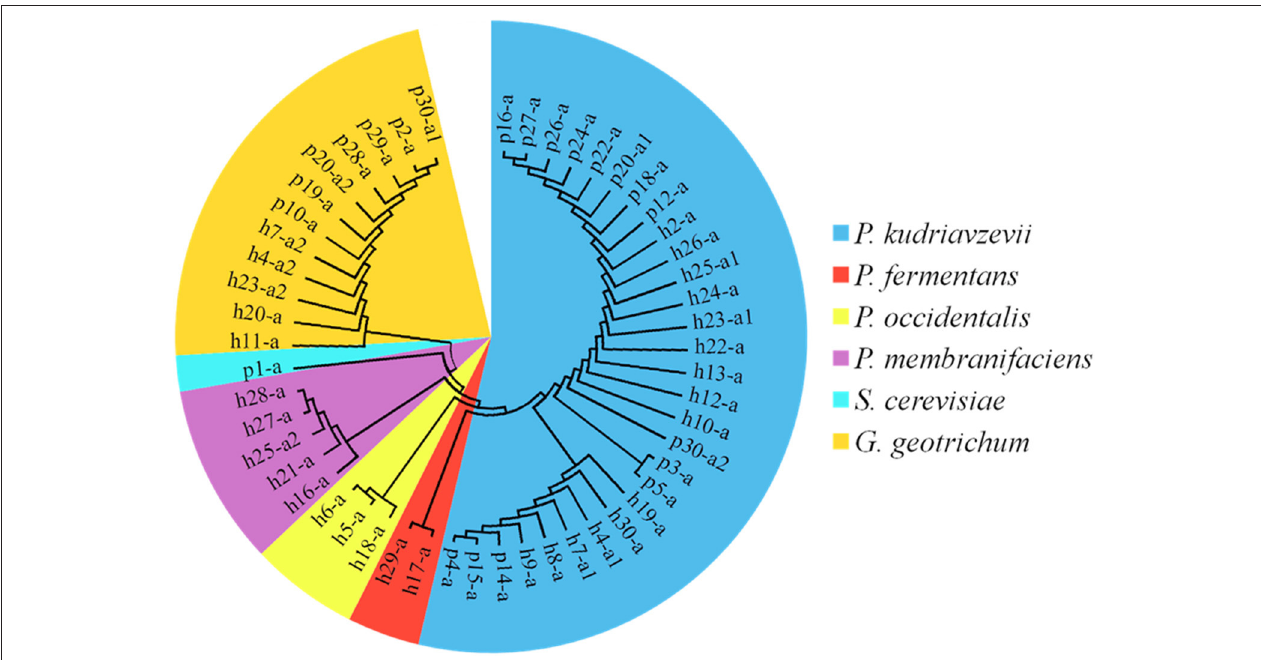
FIGURE 8 | The cladogram tree of the yeasts. The partial 18S rRNA gene sequences (928–944 bp) were analyzed using the Neighbor-Joining method. P, Pichia . S, Saccharomyces . G, Galactomyces .